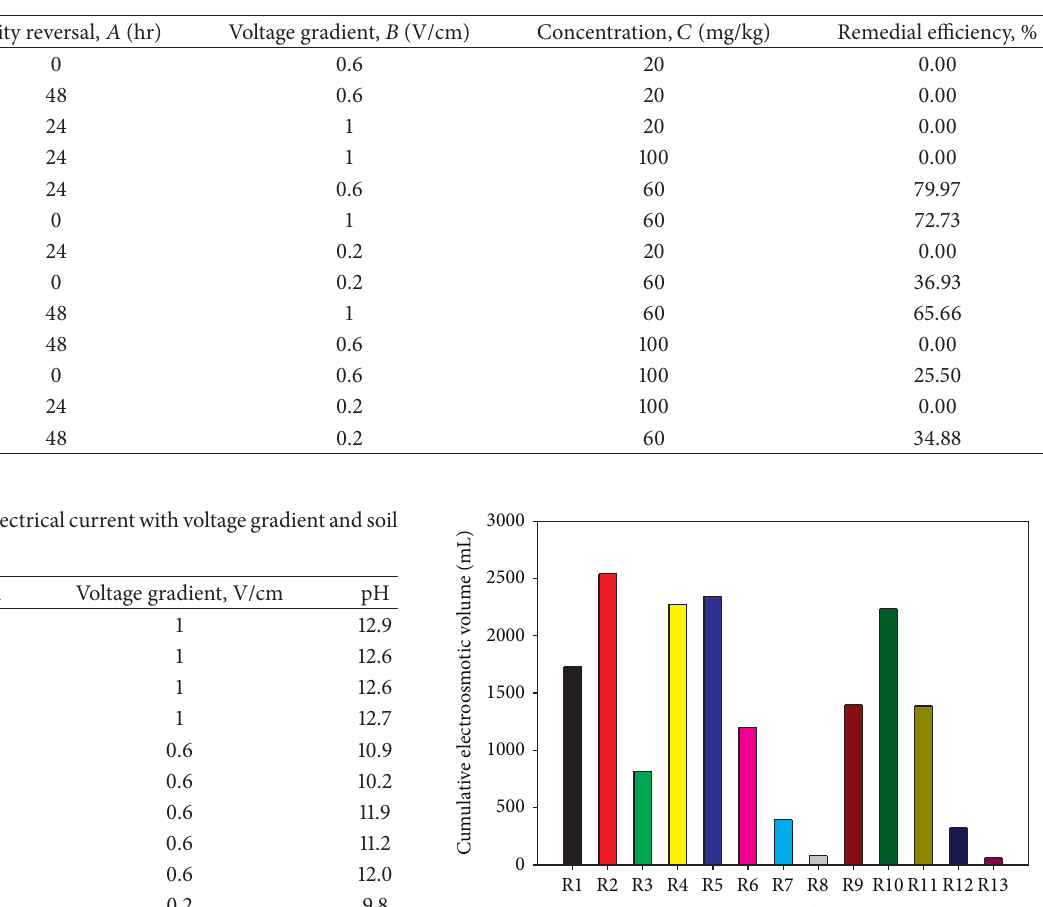
Table 4: Design of experimental runs using the Box-Behnken design.